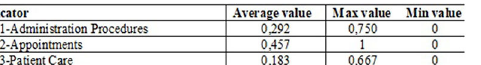
FIGURE5 Average, maximum, and minimum values obtained by each indicator composing criterion Community Interaction (C3).